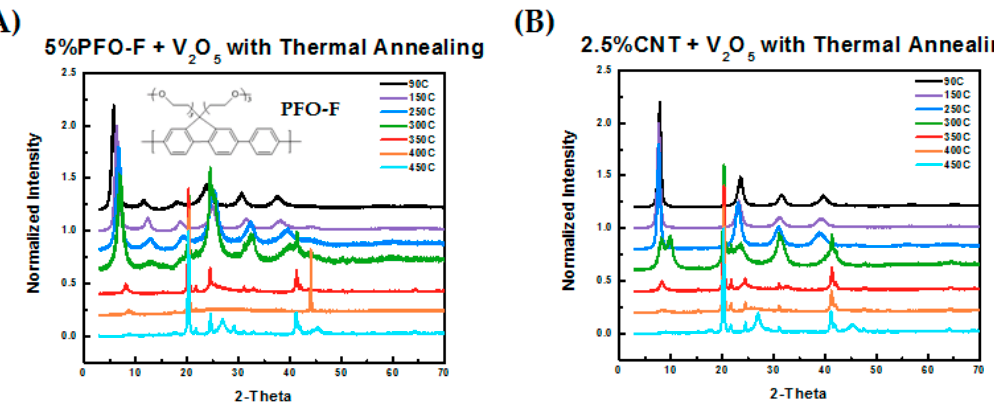
Figure 2. ( A ) Schematic of PFO-F and XRD pattern of V 2 O 5 blended with 5% PFO-F undergoing thermal annealing from 90 °C to 450 °C. ( B ) XRD pattern of V 2 O 5 blended with 2.5% carbon nanotubes (CNTs) undergoing thermal annealing from 90 °C to 450 °C.